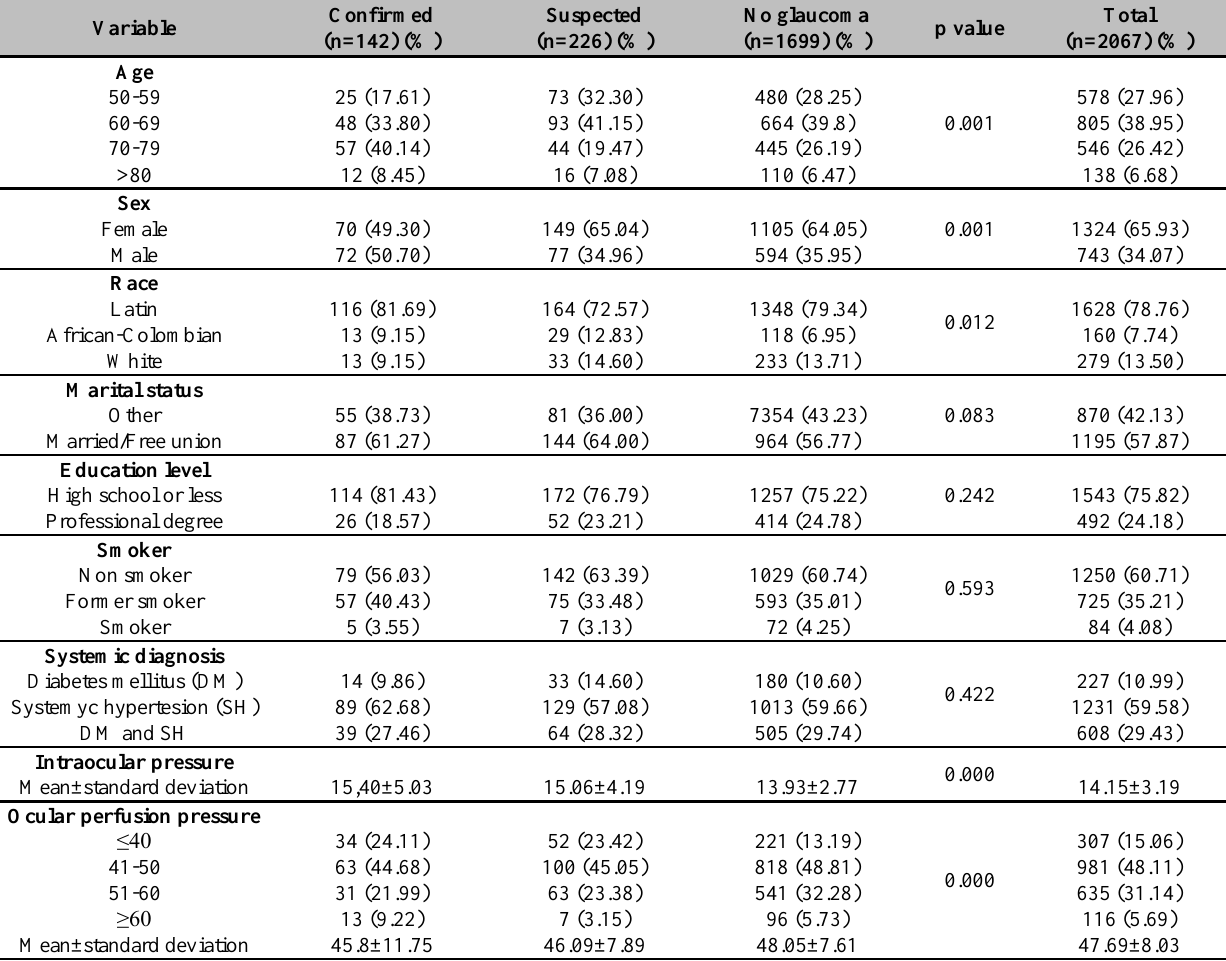
Table 1: Sociodemographic, clinical and ocular characteristics of cases with and without primary open-angle glaucoma